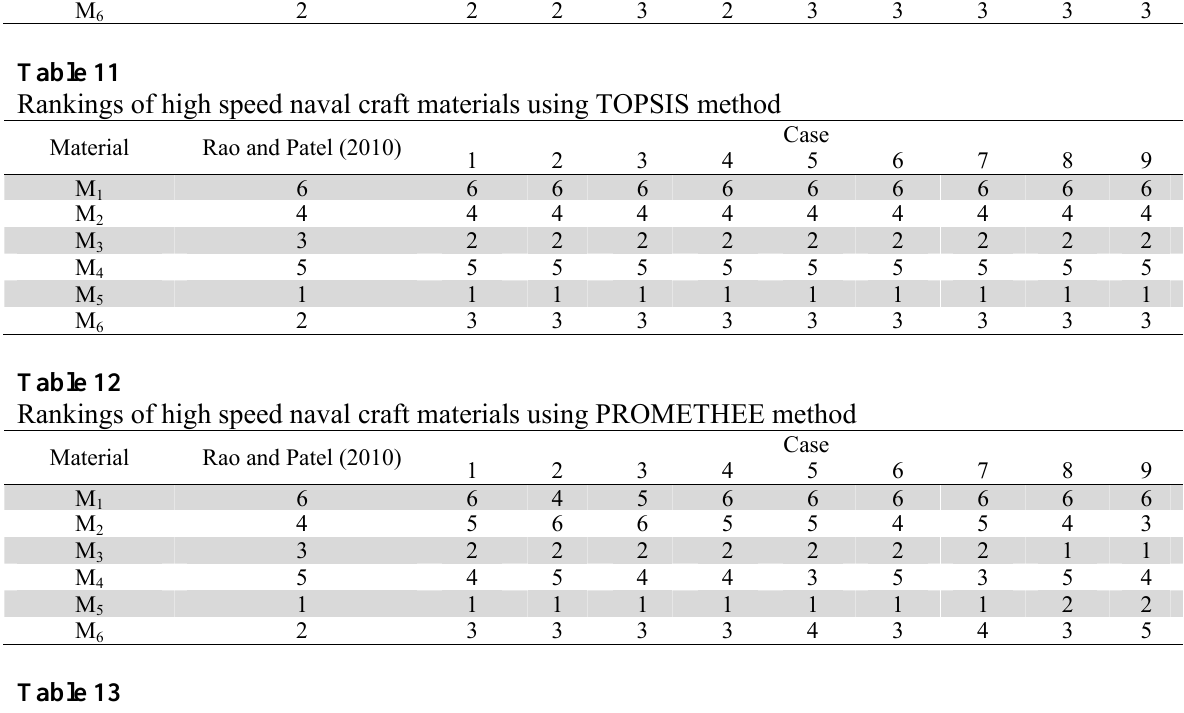
Spearman’s rank correlation coefficient values for Example 2 Method